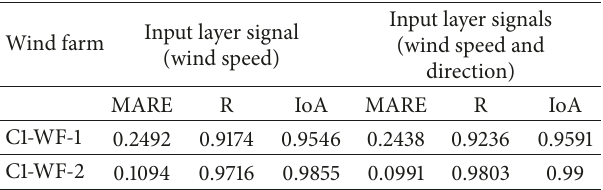
Table 4: Comparison of the results of the models generated according to (a) and (b) of Figure